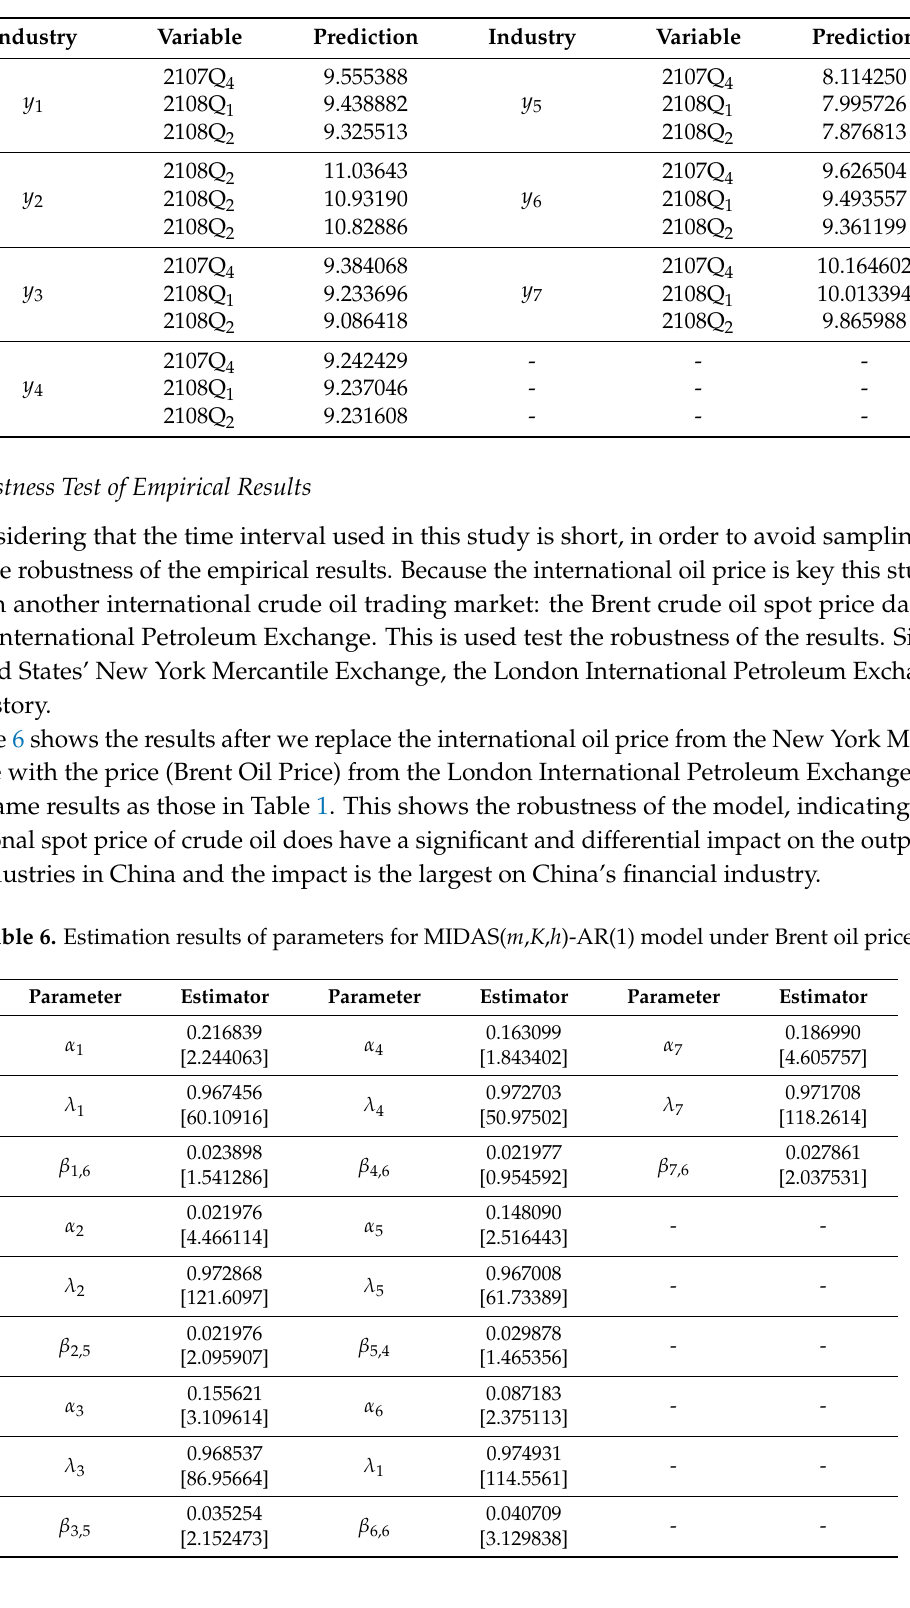
Table 5. Mixing Data Regression Model 3-Step Forward Prediction Results.